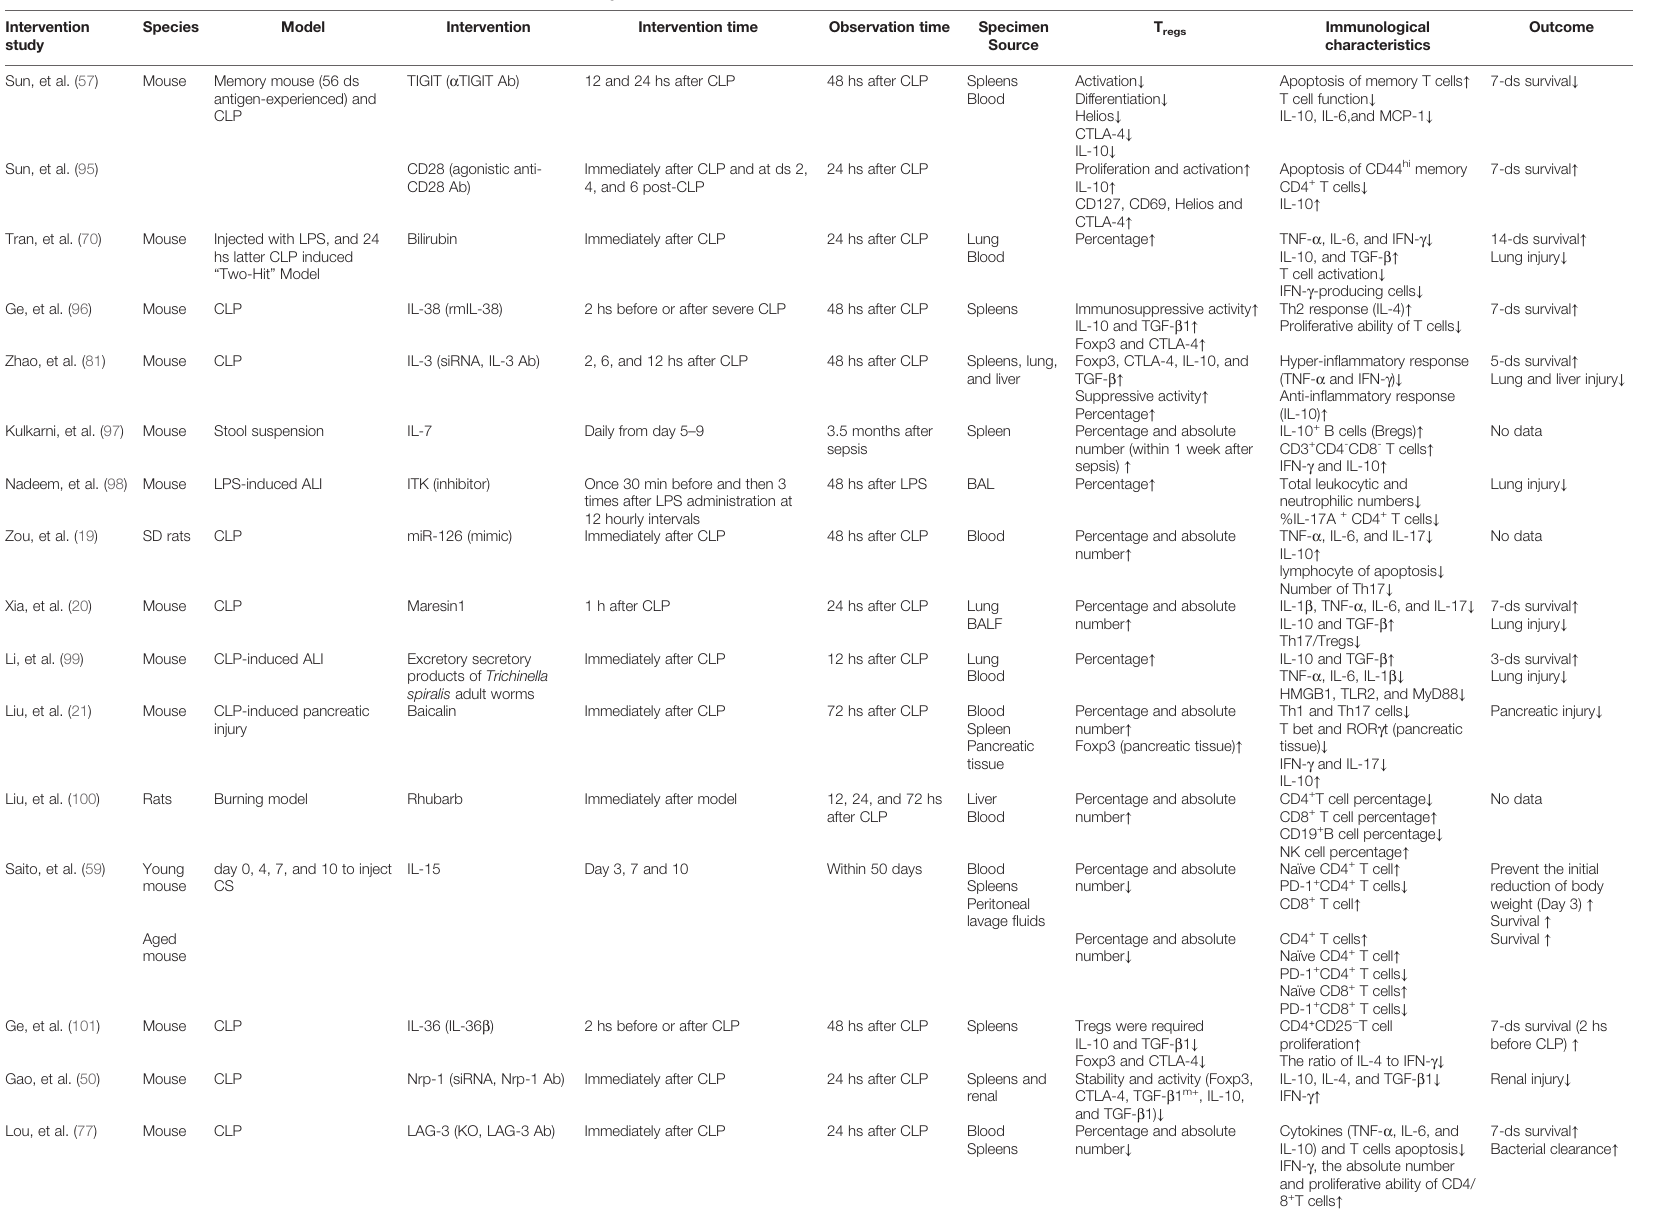
TABLE 3 | Intervention studies using animal models focused on the target of T regs in